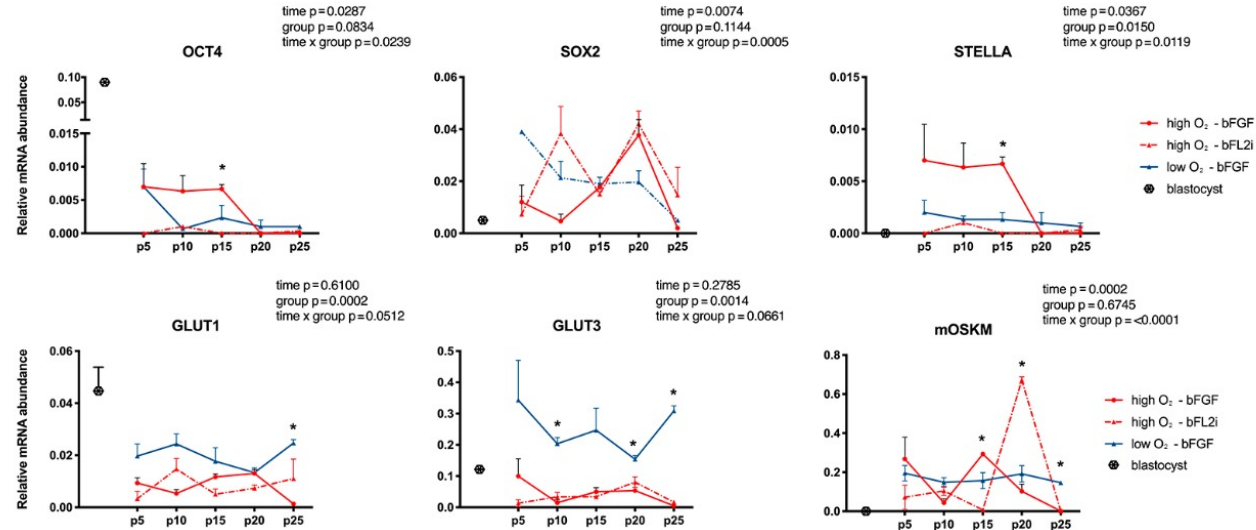
Figure 2. Gene expressions of SOX2, OCT4, STELLA (pluripotent markers), GLUT1 and GLUT3 (metabolism pathways) and mOSKM (exogenous vector) in biPSCs derived at different oxygen tensions (low × high O 2 ) and pluripotent supplements (bFGF × bFL2i). Statistical differences in time, group effect and the interaction between time and treatment were observed in each gene. Statistical differences between groups in the same passage are presented with *. The Y axis represents arbitrary units.